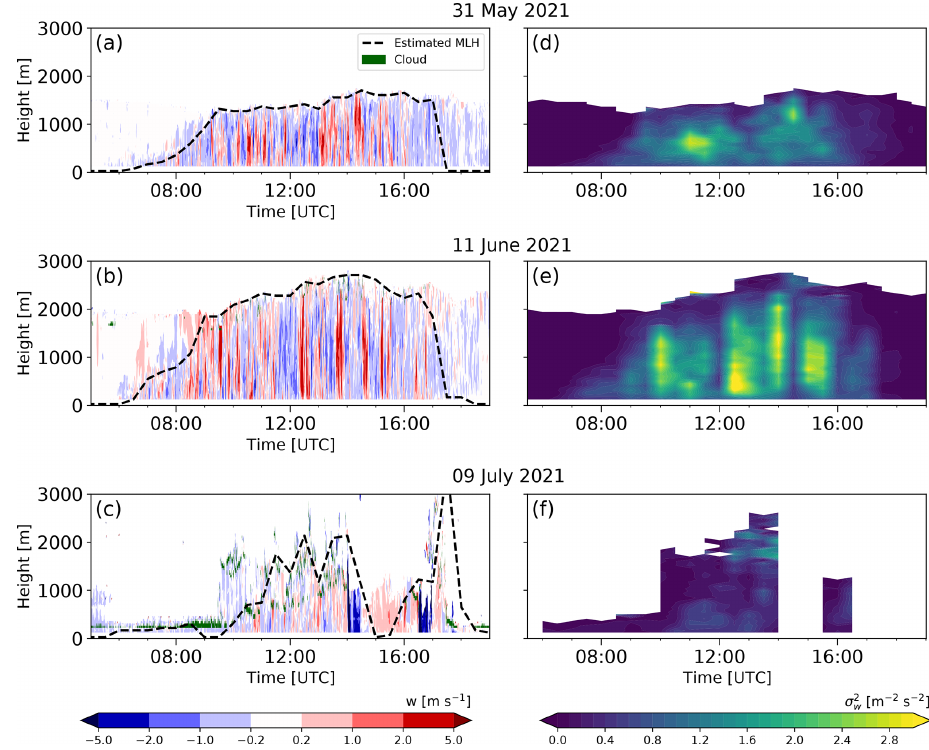
Figure 5. Example of (a–c) 1min averages of vertical velocity and (d–f) 30min averages of variance of vertical velocity on a clear-sky day (31 May 2021), cloud-topped day (11 June 2021) and rainy day (9 July 2021). The estimated mixing-layer height based on the Doppler lidar measurements is indicated by a dashed black line, while the cloud layer is given in green.